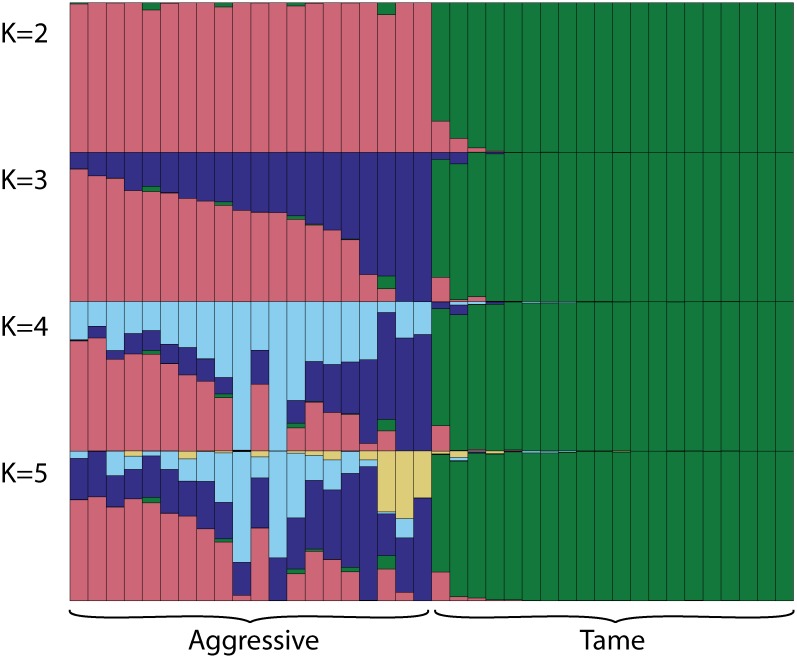
Estimation of population structure using STRUCTURE.Cluster analysis of fox genotypes was performed at four values of K (2, 3, 4, and 5) without population information. The numbers of assumed clusters are indicated on the y-axis. The population origin of individuals is indicated on x-axis. On each graph the individuals are listed in the order obtained at K = 3. Each individual is represented by a bar that is segmented into colors based on the assignment into inferred clusters given the assumption of K populations. The length of the colored segment is the estimated proportion of the individual’s genome belonging to that cluster. The analysis was run in 8 replicates for each K, the replicate with the highest likelihood is shown. The genetic structure analysis clearly differentiated the tame population from the aggressive one and did not reveal significant population stratification within the tame population at every K tested. In contrast, the population stratification within the aggressive population became apparent at K = 3.